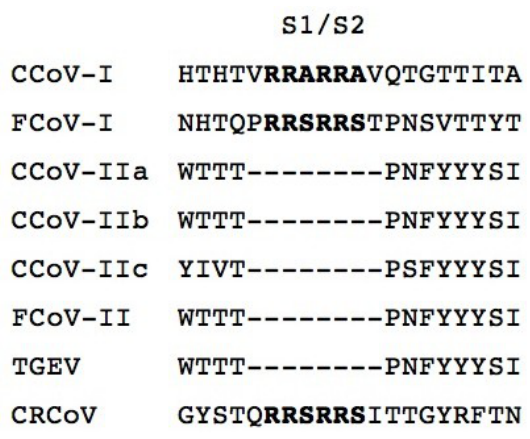
Figure 3. Multiple sequence alignment of the spike proteins of representative coronaviruses of cats (FCoV) dogs (CCoV and CRCoV) and pigs (TGEV) (The following virus sequences were used for alignment. FCoV-I = RM (ACT10854); FCoV-II = WSU-79-1683 (AFH58021.1); CCoV-IIa = CCoV CB/05 (AAZ91437.1); CCoV-IIb = CCoV 341/05 (ACJ63231.1); CCoV-I = CCoV Elmo/02 (AAP72149.1); CCoV-IIc = CCoV-A76 (AEQ61968.1); CRCoV = CRCoV4182 (ABG78748.1); TGEV (CAB91145.1).), in the region of the two activation sites (S1/S2 and S2’). The alignment was created using ClustalX [45]. The expected cleavage motif is in